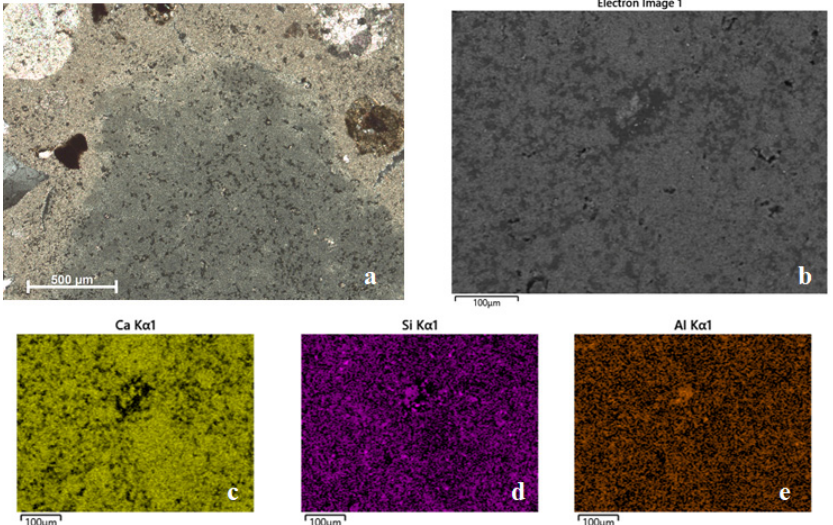
Figure 9. Microphotographs of small dark inclusions in the binder of a bedding mortar of the Trebbio castle tower, located in Mugello, near Florence (15th century); ( a ) under PLM, xpl; ( b ) BS image of a particular of this binder portion in which areas with different grey tones can be observed; ( c ) SEM EDS map of Ca; ( d ) SEM EDS map of Si; and ( e ) SEM EDS map of Al.